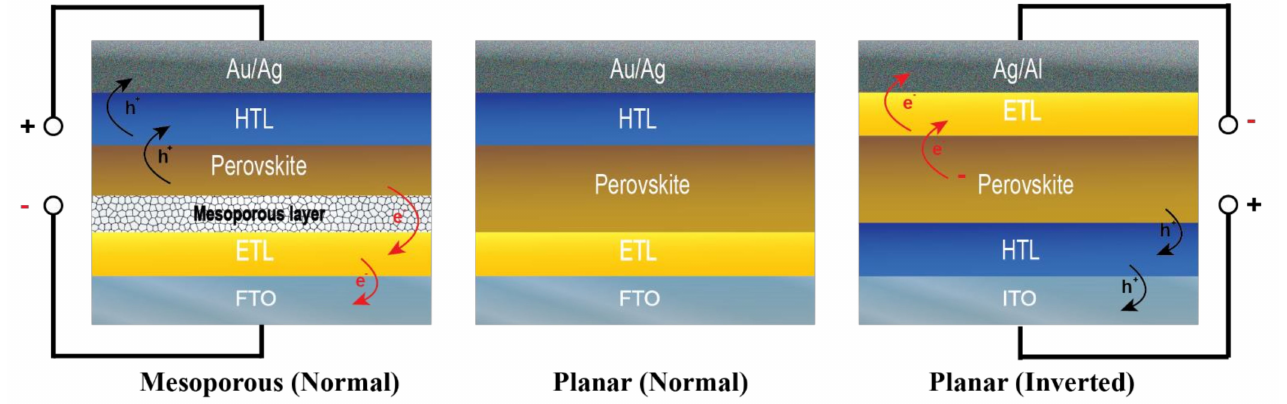
Figure 1. Types of perovskite solar cells, mesoporous and planar